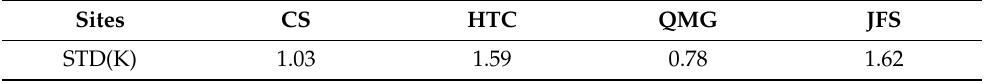
Table 2. The spatial standard deviation (STD) of validation sites used in this study.